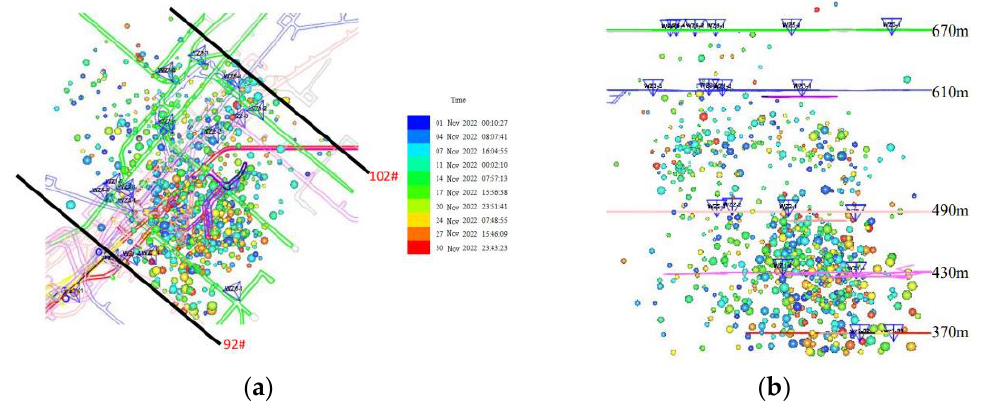
Figure 7. Spatial distribution of microseismic events in the I# mineral belt area: ( a ) top view; ( b ) east view. Different colored balls indicate different monitored dates; triangles indicate sensor locations; 370 m, 430 m, 490 m, 610 m, 670 m. indicate different mining levels.